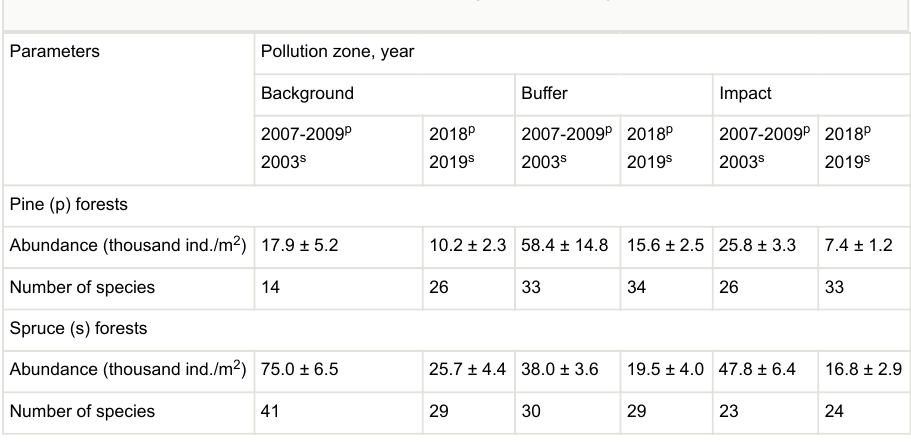
Abundance and species number of Collembola along the pollution